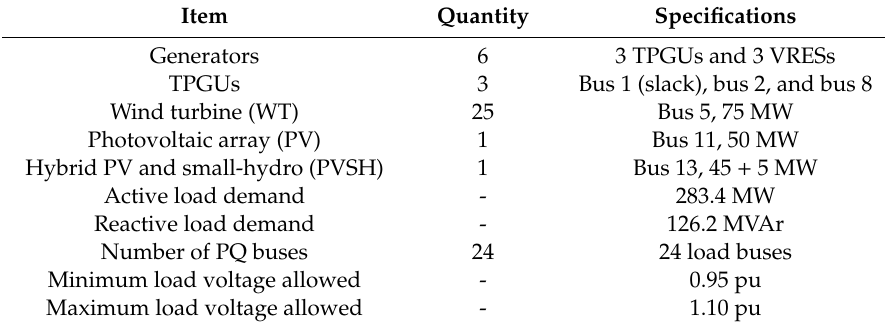
Figure 1. Adopted IEEE 30-bus system studied. Table 3. The model specifications [24].